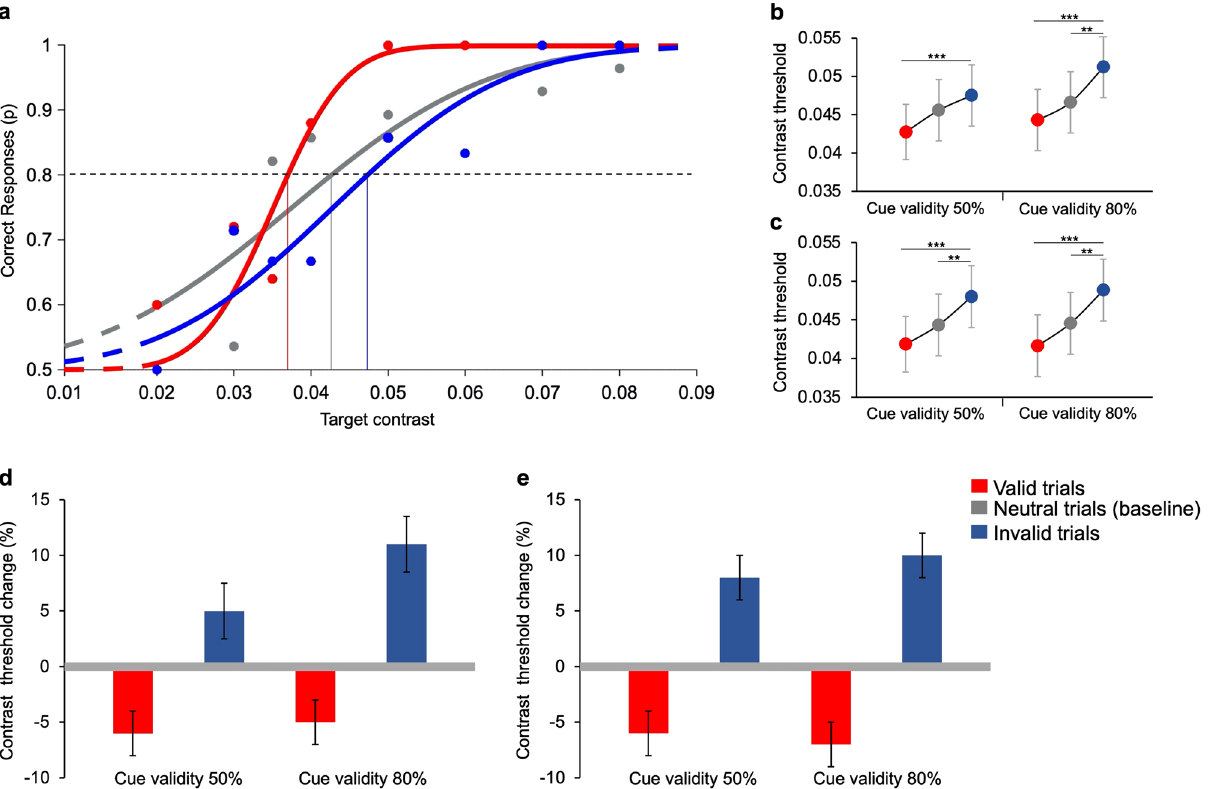
Figure 3. Contrast thresholds in valid, invalid, and neutral trials. (a) Example of correct responses as a function of target contrast for one participant. Performance obtained in the experimental condition with 80% cue validity. Data are obtained from 224 neutral trials, 200 valid trials, and 50 invalid trials. Filled circles represent the proportion of times in which the participant correctly discriminated the gabor orientation presented with a specific contrast. The curves represent cumulative Gaussian error fits of the data. The vertical lines represent contrast thresholds, i.e., contrast values yielding 80% correct responses (dashed line). The color coding of dots, curves and lines is red for valid, blue for invalid, and grey for neutral trials. (b) Experimental condition. Group average contrast thresholds in neutral (grey), valid (red), and invalid (blue) trials. Post-hoc t -tests (Bonferroni correction) show a significant difference between valid versus invalid trials for 50% cue validity ( t (2) = 5.12, p < 0.001), They show also significant differences between valid versus invalid trials ( t (2) = 6.05, p < 0.001), and invalid versus neutral trials ( t (2) = − 4.07, p = 0.002) for 80% cue validity. (c) Control condition. Group average contrast thresholds in neutral (grey), valid (red), and invalid (blue) trials. Post-hoc t-tests (Bonferroni correction) show a significant difference between valid versus invalid trials ( t (2) = 6.52, p < 0.001), and invalid versus neutral trials ( t (2) = − 3.73, p = 0.006) for 50% cue validity. They also show significant differences between valid versus invalid trials ( t (2) = 6.26, p < 0.001), and invalid versus neutral trials ( t (2) = − 3.64, p = 0.009) for 80% cue validity. Asterisks mark statistically significant pairwise comparisons across trial types: ** p < 0.01, *** p < 0.001. Error bars are SEM. (d) Experimental condition. Group average threshold changes in valid (red) and invalid (blue) trials compared to the baseline (grey line, neutral trials with two non-optimal features). (e) Control condition. Group average threshold changes in valid and invalid trials compared to the baseline (neutral trials with two identical low-luminance grey